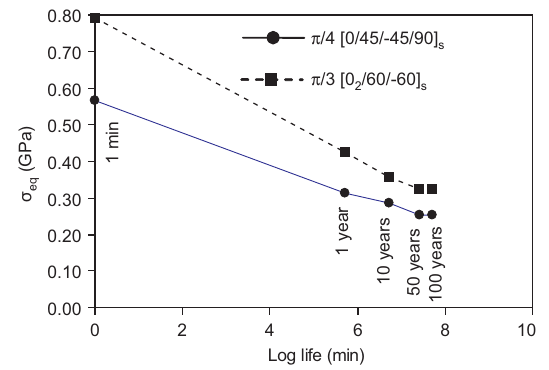
Figure 22 Tensile σ for π /3 and π /4